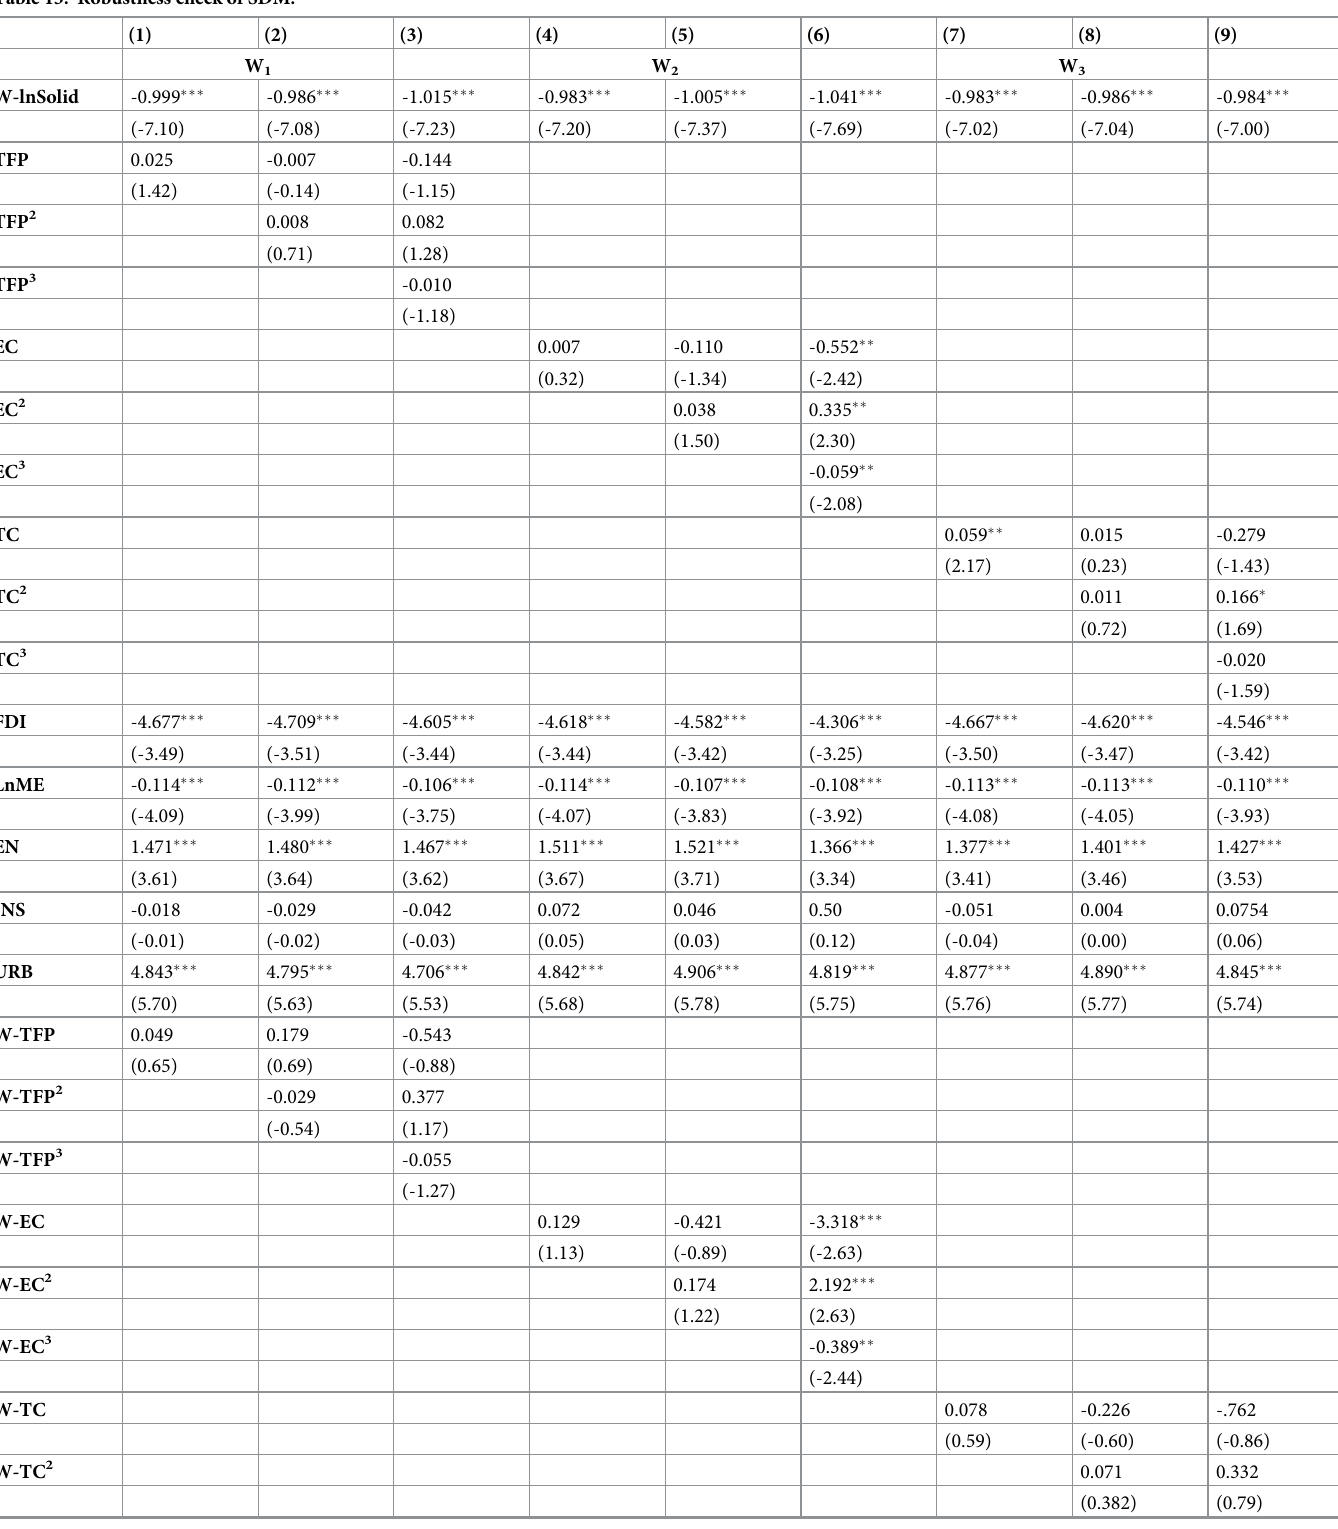
Table 13. Robustness check of